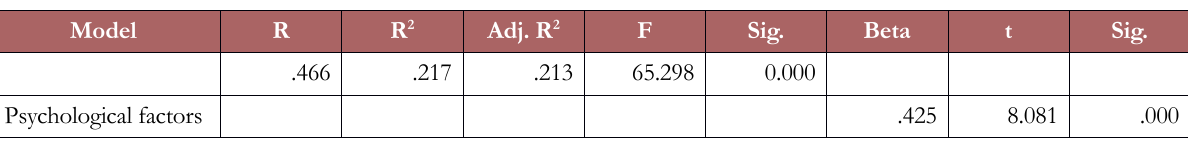
Table 8. Linear regression model for psychological factors- implementation of 5S and TPM